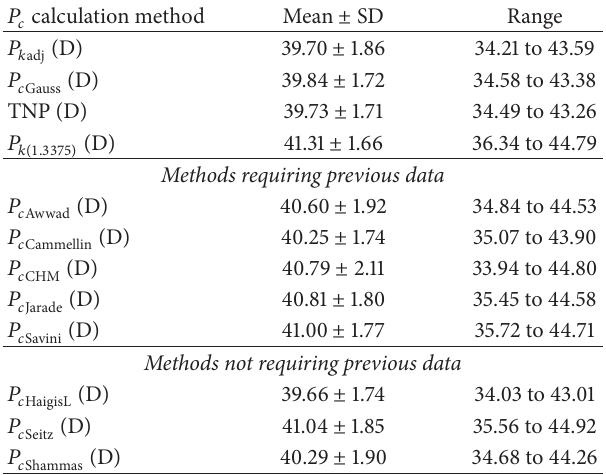
Table 2: Corneal power measured with different